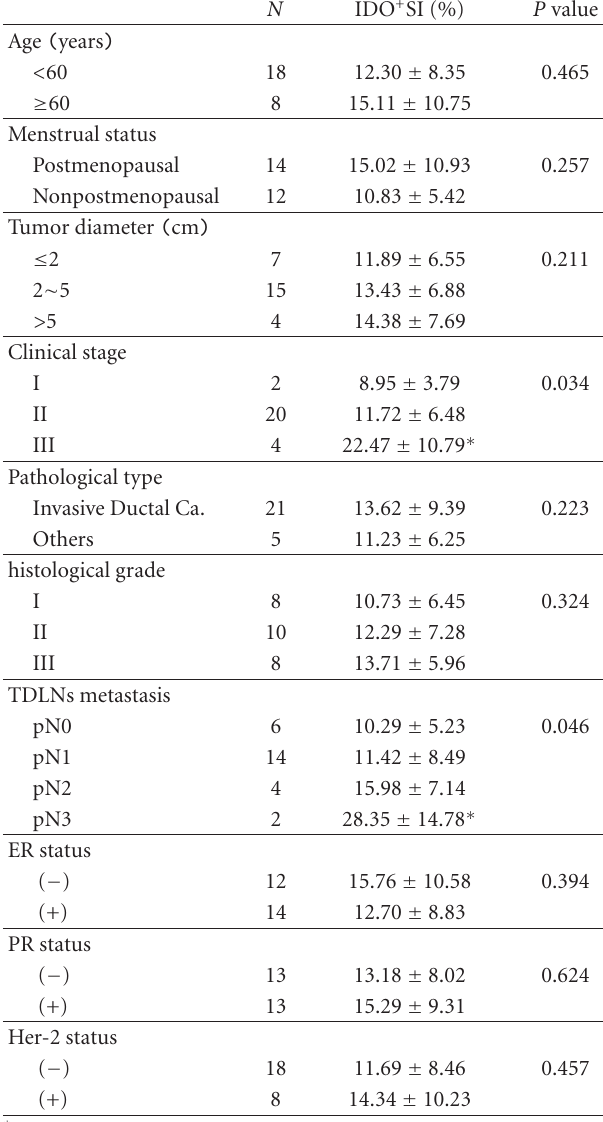
Table 2: The relationship between IDO expression and clinical pathological